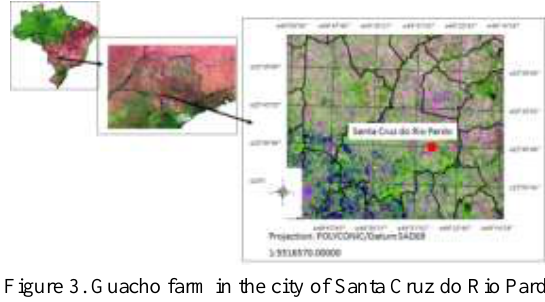
Figure 3. Guacho farm in the city of Santa Cruz do Rio Pardo. City of Santa Cruz do Rio Pardo in Sao Paulo State and in Brazil.